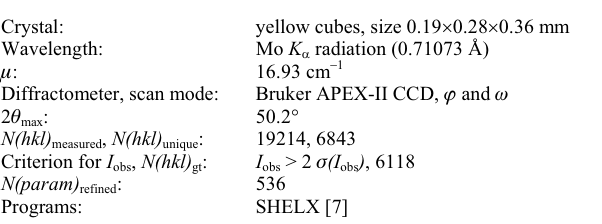
Table 1. Data collection and handling.